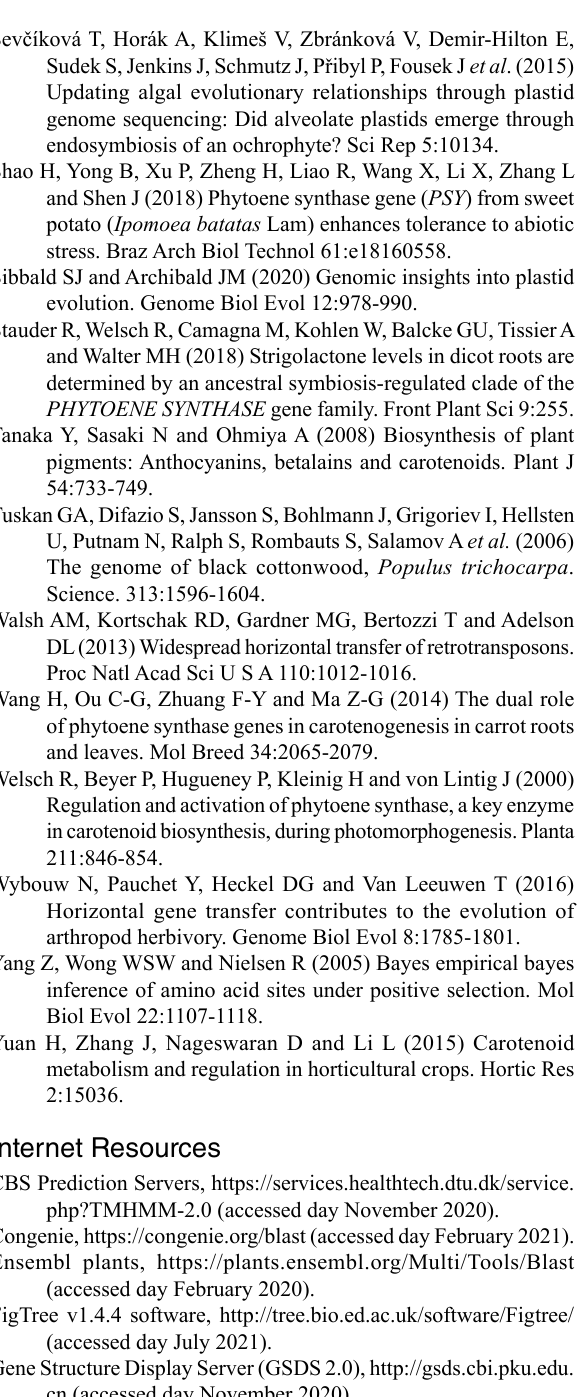
FigTree v1.4.4 software, http://tree.bio.ed.ac.uk/software/Figtree/